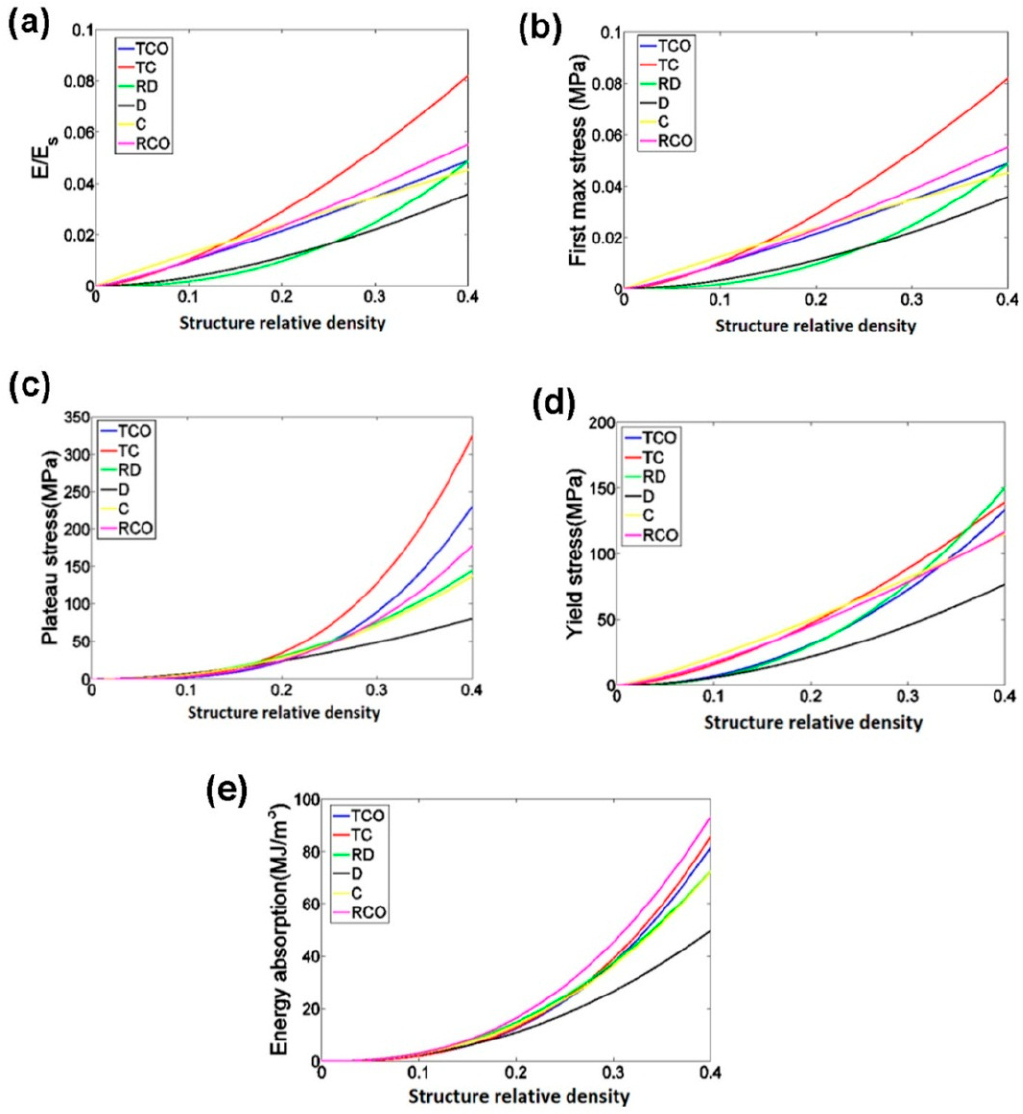
Figure 7. Comparison between the mechanical properties of different types of porous structures based on the six different unit cells: ( a ) elastic gradient; ( b ) first maximum stress; ( c ) plateau stress; ( d ) yield stress; ( e ) energy absorption. In these figures, the exponents of the power law fitted to the experimental data points, but not the experimental data points themselves, are compared with each other [39].